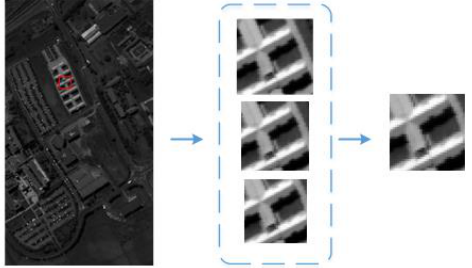
Figure 1. The proposed HSI classification method overview — training flow. For illustrative pur- poses, a single image flow instead of a batch is shown here. Stage 1: pre-training based on super- vised contrastive learning. Stage 2: fine-tuning for the final classification task.